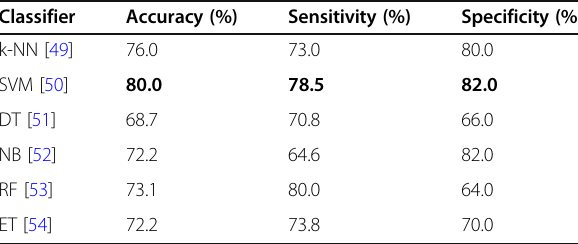
Table 4 Classification results were obtained for six different state-of-the-art classifiers using a set of all 125 features